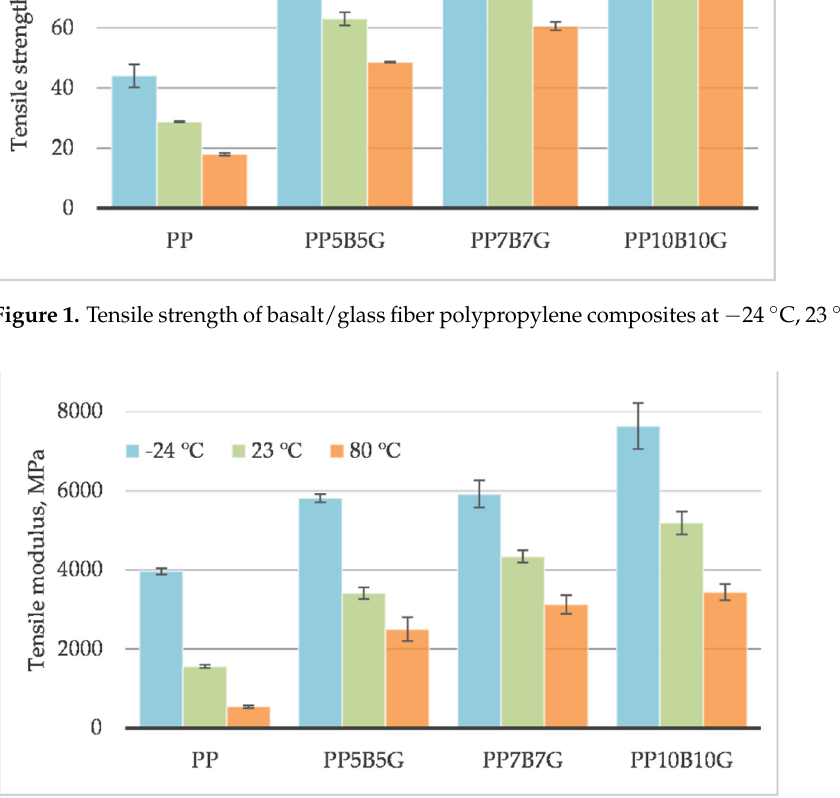
Figure 2. Tensile modulus of basalt/glass fiber polypropylene composites at − 24 °C, 23 °C, and 80 °C .